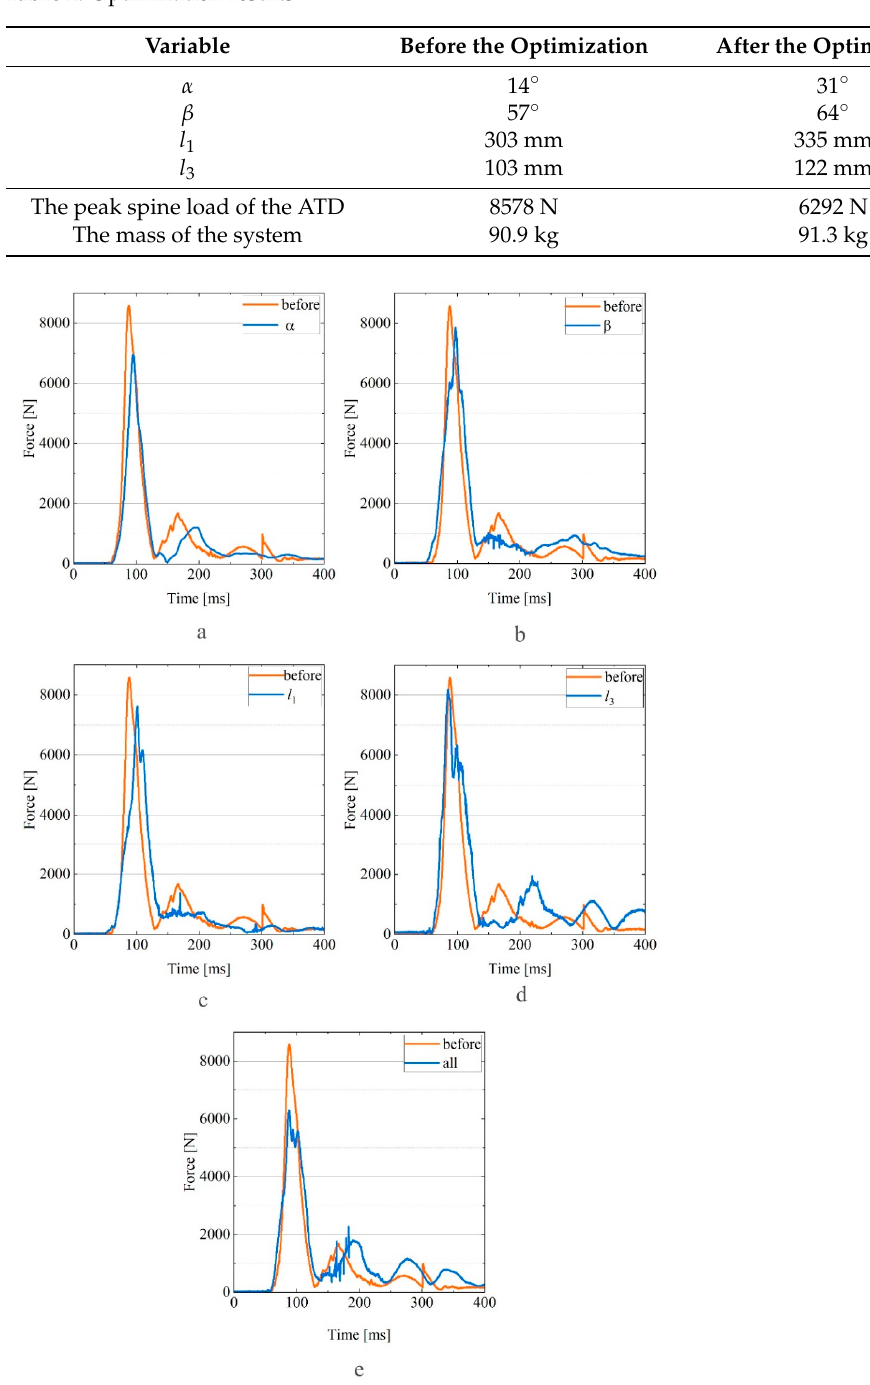
Figure 10. Comparison of the spine load before and after the optimization. ( a ) The optimized variable is α . ( b ) The optimized variable is β . ( c ) The optimized variable is l 1 . ( d ) The optimized variable is l 3 . ( e ) The optimized variables are α , β , l 1 and l 3